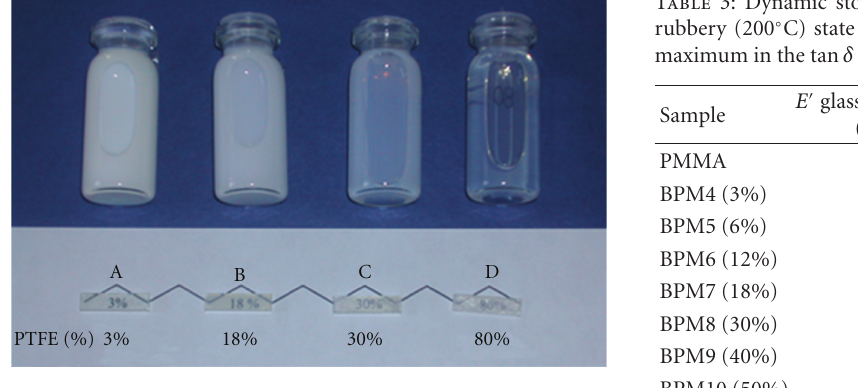
Figure 8: (A): BPM4 ( d = 112nm, 3% PTFE); (B): BPM7 ( d = 54nm, 18% PTFE); (C): BPM8 (48nm, 30% PTFE); (D): BPM11 ( d = 35nm, 80% PTFE).